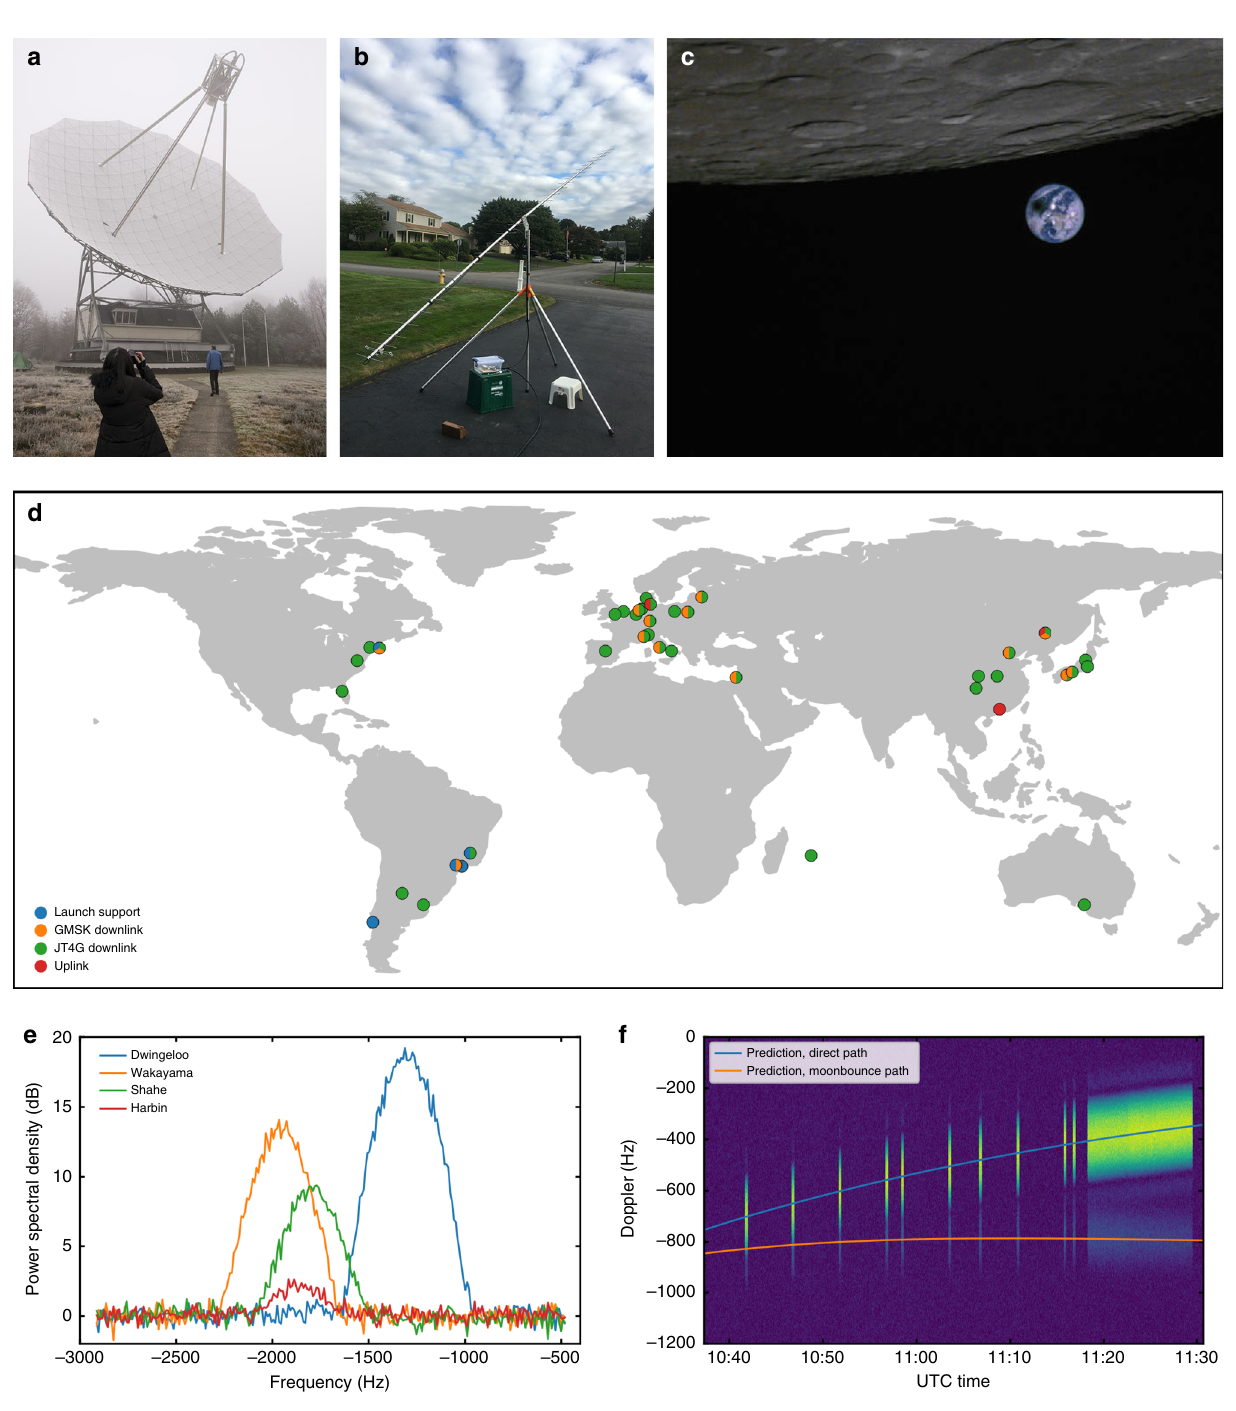
Fig. 4 Operation of VHF/UHF radio. a Dwingeloo 25 m radio telescope (PI9CAM) in the Netherlands, as the largest participating ground station antenna. b 28-element Yagi antenna on a tripod, used by radio amateur Robert Mattaliano (N6RFM) in the US, as an example of a small ground station antenna. c Image of the 2 July 2019 total solar eclipse (color corrected). d Positions of the ground stations taking part in the operation of the VHF/UHF radio. e Spectrum plot of GMSK downlink received by different ground stations. f Waterfall plot of GMSK downlink from direct path and moonbounce path comparing with